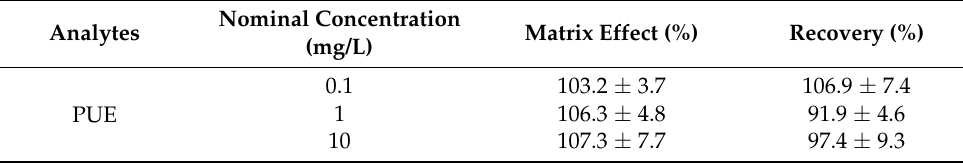
Table 2. The recoveries and matrix effects of PUE in rat plasma.